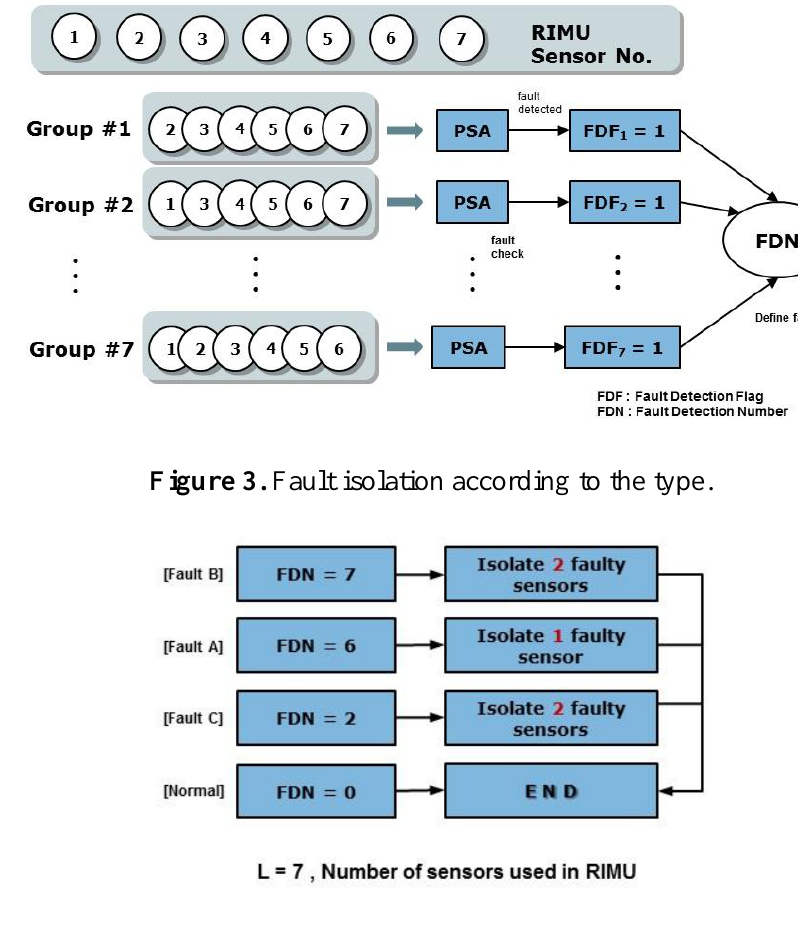
Figure 2. Fault detection using EPSA.